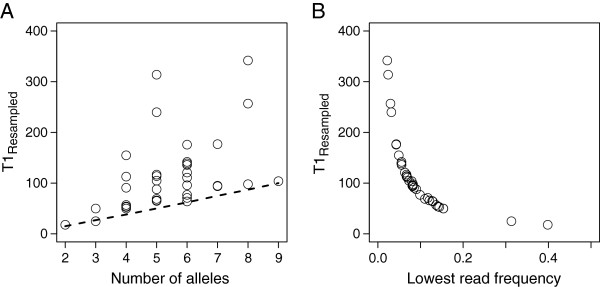
Influence of the individual number of alleles (A), and the lowest read frequency (B) on the minimum number of reads required to determine a complete genotype with a 99.9% confidence level. Each point represents a different individual (N = 36). The minimum number of reads required was a posteriori computed (T1Resampled) by resampling both amplicon replicates (T1Resampled1, T1Resampled2) and the maximal value was retained. The dashed line in (A) illustrates T1Galan Simul computed according to Galan’s et al. [13] definition of an allele’s dropout (i.e. an allele associated with two reads or less; see text for details).